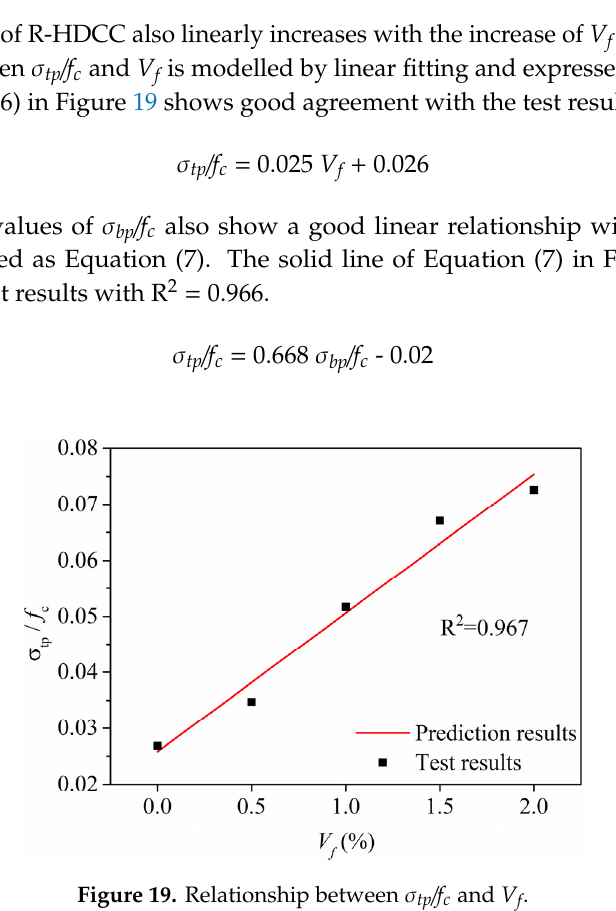
Figure 18. Relationship between σ bp /f c and V f .